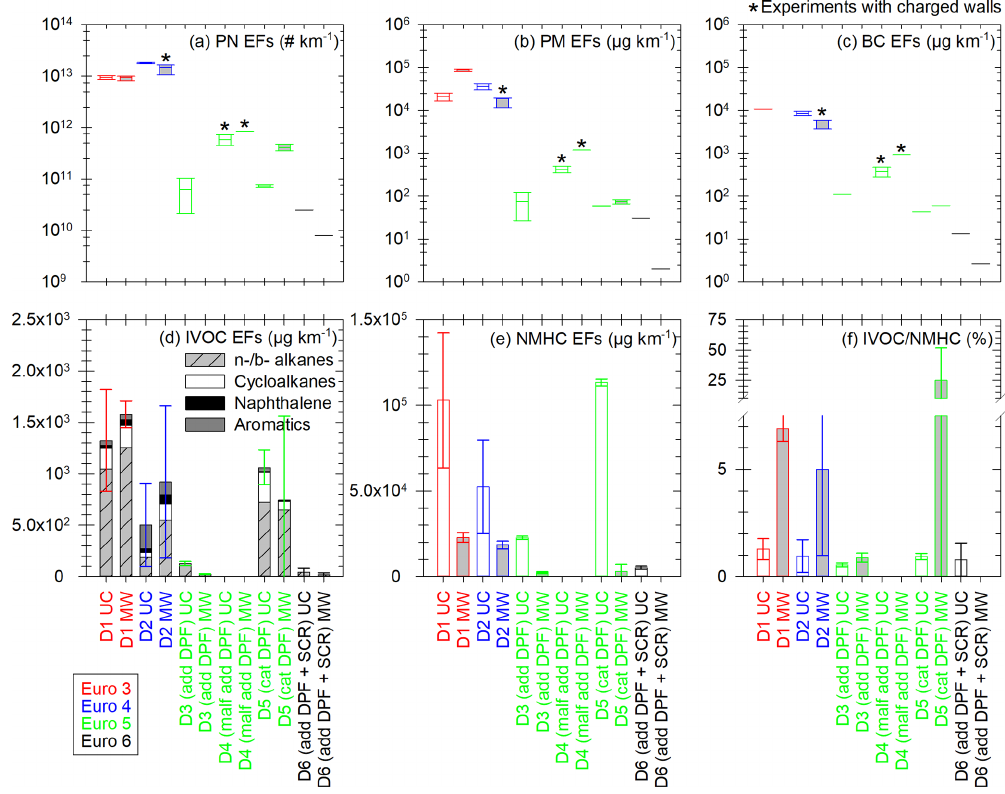
Figure 6. Emission factors of PN (a) , PM (b) , BC (c) , IVOCs (d) and NMHCs (e) , and IVOC / NMHC ratio (f) for the six tested Euro 3–6 diesel vehicles UC (white) and MW (light grey) conditions. IVOC EFs (d) are the sum of EFs of linear and branched (n- and b-, respectively) alkanes (hatched grey), cycloalkanes (white), naphthalene (black) and aromatics (dark grey), with retention times in the range corresponding to C 12 –C 22 alkanes. EFs are given in µgkm − 1 and the IVOC / NMHC ratio in percentage. Vehicles are sorted by Euro norm: Euro 3 in red, Euro 4 in blue, Euro 5 with add or cat DPF in green and Euro 6 in black. The Euro 5 vehicle showing signs of malfunctioning DPF is referred to as “D4 (malf add DPF)”. The boxes represent the 25th and 75th percentiles. The solid line in the center represents the median. The whiskers are the 10th and 90th percentiles. Error bars represent 1 standard variation in panels (d) to (f) . Panel (f) has a broken axis to better show the smaller values. The boxplots with the sign * represent the cycles for which chamber initial concentrations can be impacted by electrostatic charge on the walls. It could only impact PN, PM and BC, since IVOCs and NMHCs were sampled directly from